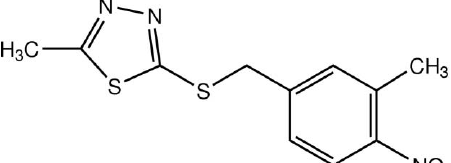
Data collection Bruker APEX DUO CCD area- detector diffractometer Absorption correction: multi-scan ( SADABS ; Bruker, 2009)